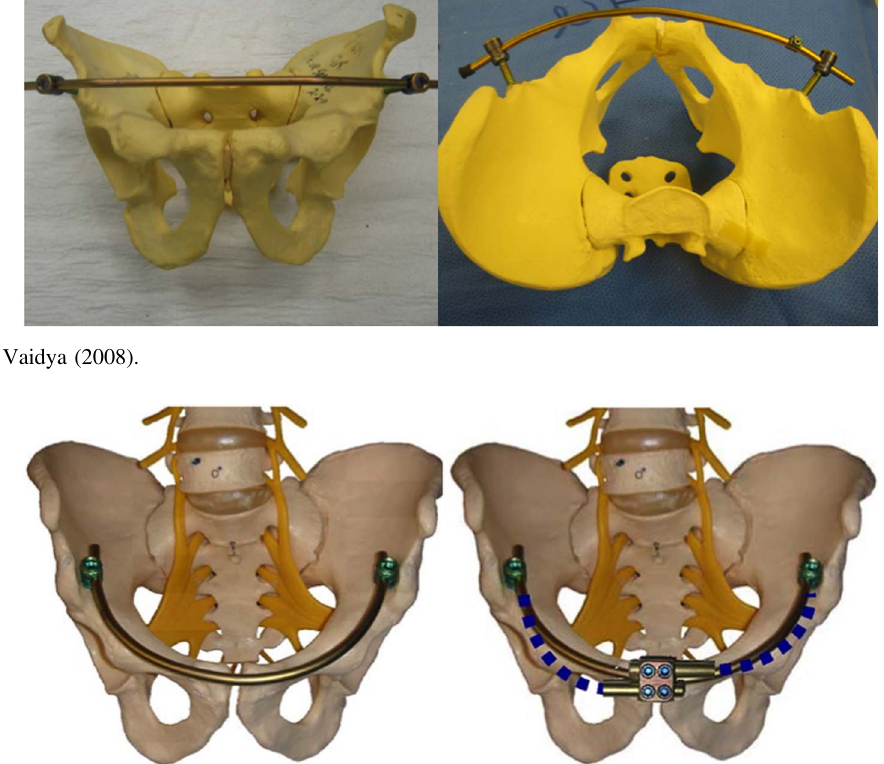
Figure 3. Kuttner et al. (2009) “ The Cross-over Pelvic Internal Fixator ” .